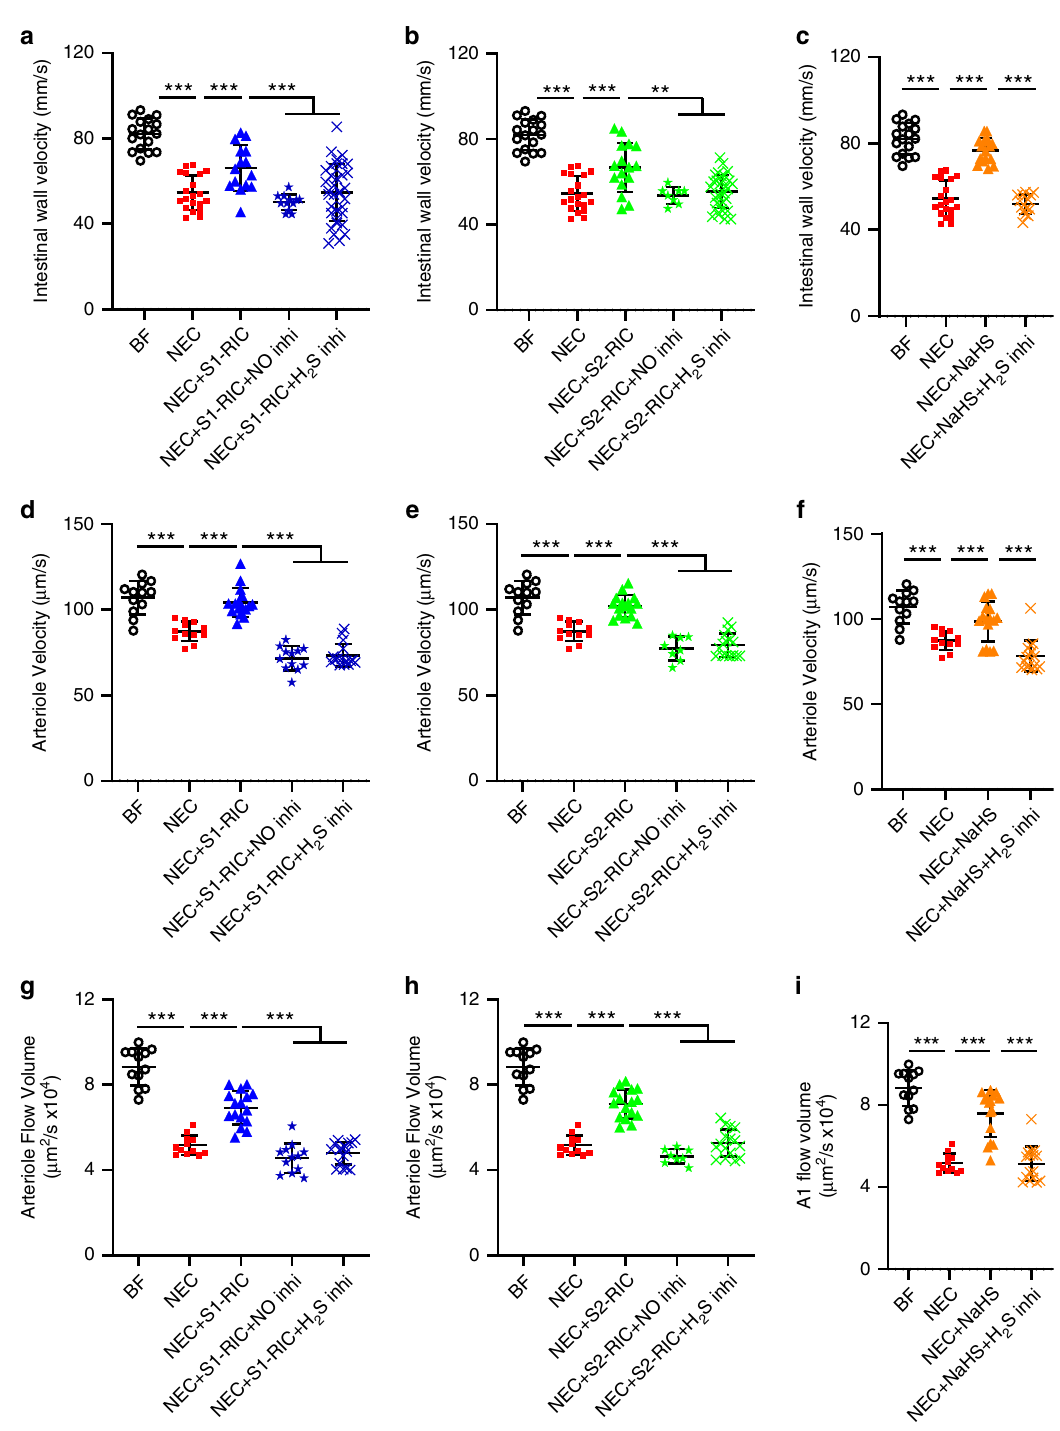
Fig. 6 RIC preserves intestinal microcirculation via endogenous vasodilators nitric oxide and hydrogen sul fi de. Administration of NO-synthase inhibitor and H 2 S-synthesizing enzyme inhibitors abolished a Stage 1 RIC and b Stage 2 RIC-mediated preservation of intestinal wall fl ow velocity (mm/s) measured with Doppler ultrasound. c Treatment with NaHS, exogenous donor of H 2 S, improved intestinal wall fl ow velocity (mm/s), but not in the presence of H 2 S- synthesizing enzyme inhibitors. Administration of NO-synthase inhibitor and H 2 S-synthesizing enzyme inhibitors abolished the d , g Stage 1 RIC- and e , h Stage 2 RIC-mediated preservation of submucosal arteriole velocity ( µ m/s) and arteriole fl ow volume [( μ m) 3 /s] respectively, measured using TPLSM in real time. f , i Treatment with NaHS improved submucosal arteriole velocity ( µ m/s) and arteriole fl ow volume [( μ m) 3 /s] respectively, but not following administration of H 2 S-synthesizing enzyme inhibitors. Data were compared using two-sided one-way ANOVA with post hoc Turkey test ( n = 8 per group; minimum of 2 readings were obtained per group; ** p < 0.01; *** p < 0.001). Data are presented as mean ± SEM. Source data are provided as a Source Data fi